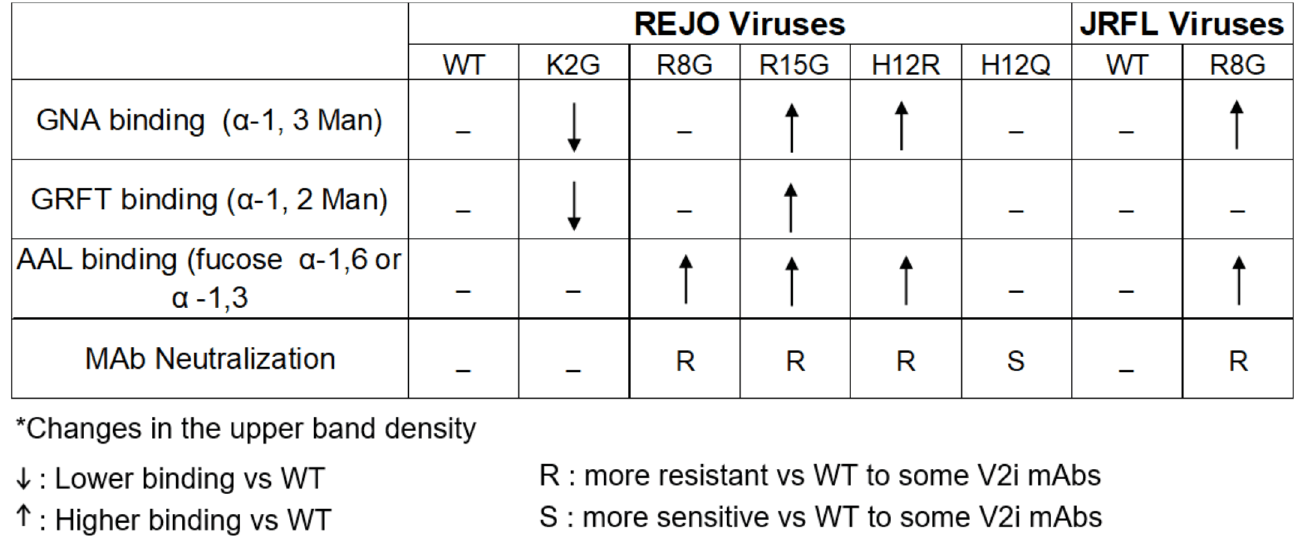
Fig 7. HIV phenotypes with Env SP mutation relative to WT (cid:3) .